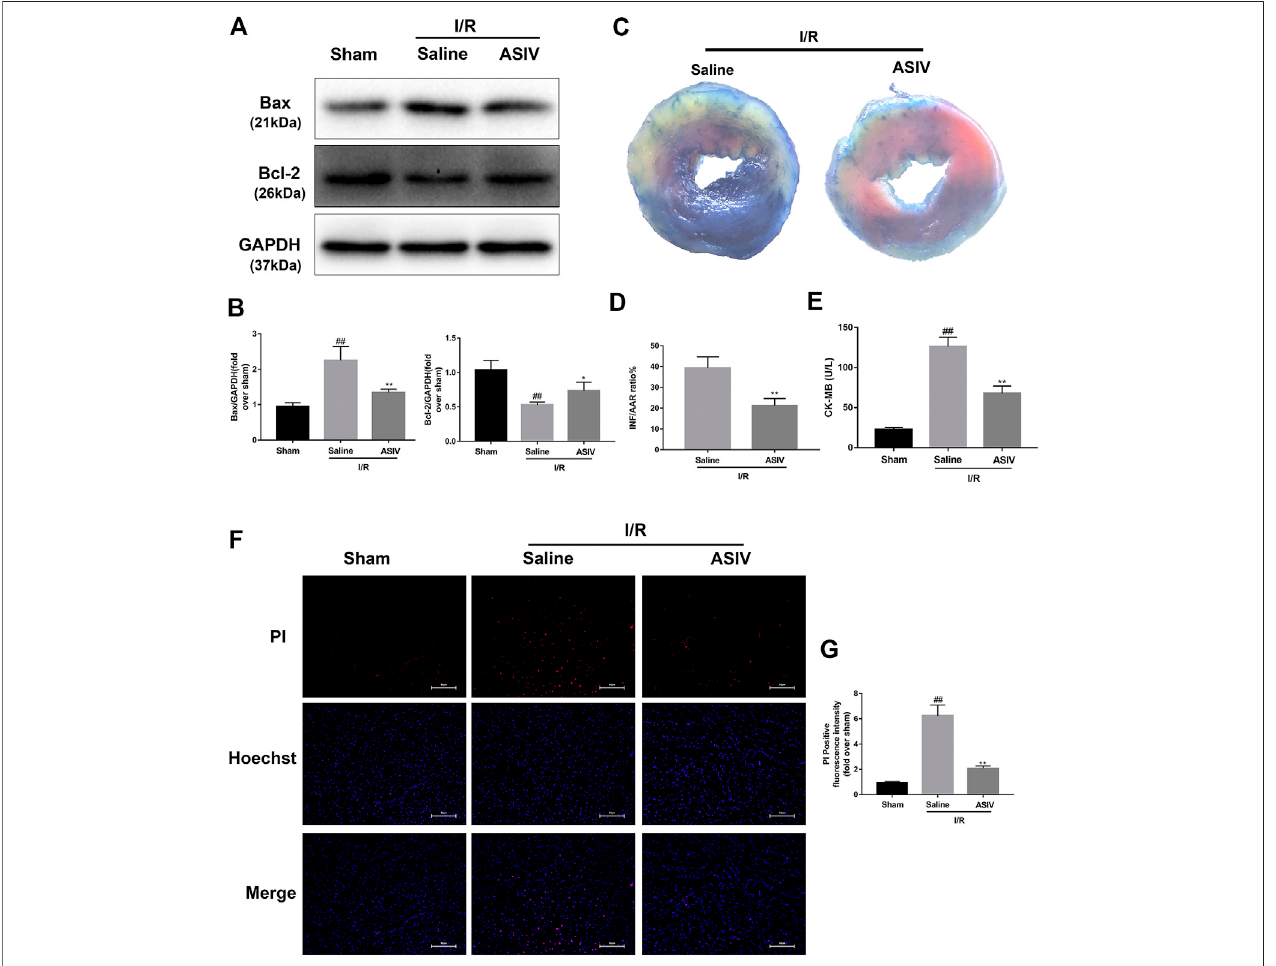
FIGURE 1 | ASIV attenuates I/R injury in vivo . Mice were treated with ASIV (20 mg/kg; i.p.) during reperfusion, (A, B) western blot results of Bax and Bcl-2 in the sham group, I/R group and ASIV treatment group were analyzed, ( C, D) TTC stain, (E) CK-MB release were analyzed after reperfusion for 4 h. (F, G) PI stain were analyzedafterreperfusionfor24 h.Scalebar:50 μ m n (cid:2) 6.Valuesareexpressedasthemeans ± SD.# p < 0.05comparedwiththeshamgroup,* p < 0.05comparedwith the I/R group (each test was repeated three times).